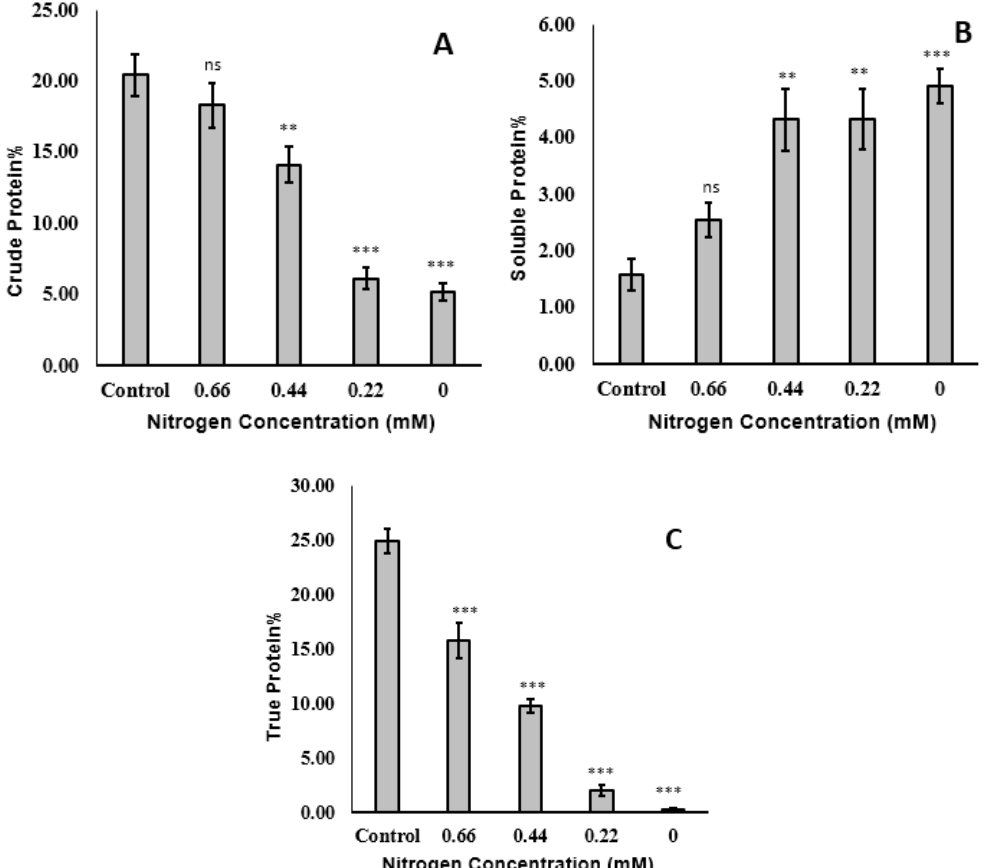
Figure 2. Crude protein ( A ), soluble protein ( B ), and true protein ( C ) content (as % dry weight (DW)) of Tisochrysis lutea grown mixotrophically in different concentrations of NaNO 3 . ** p < 0.01, *** p < 0.001, ns: not significant with respect to the control (0.88 mM).